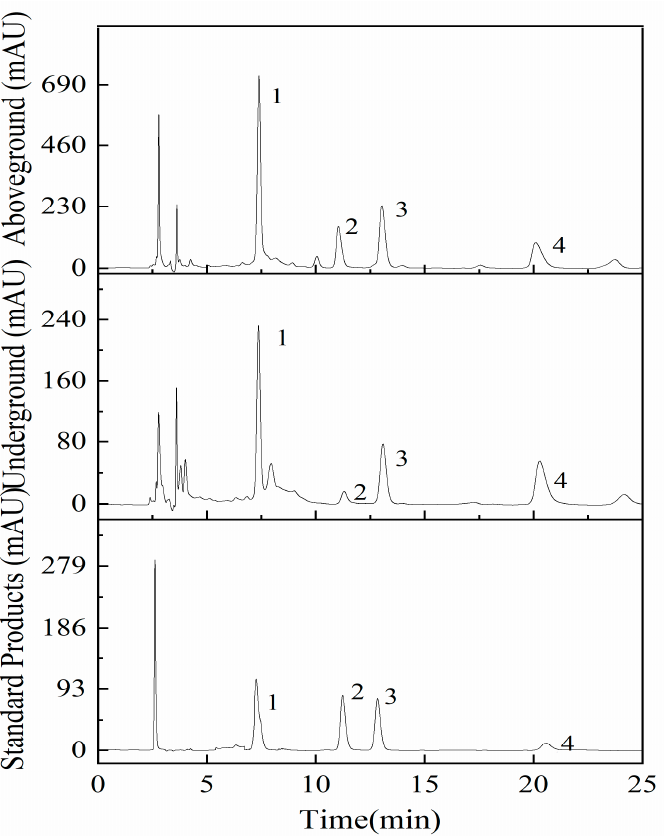
Figure 7. High-performance liquid chromatography of A. tanguticus (1 was anisodine; 2 was aniso- damine; 3 was scopolamine; 4 was atropine) .